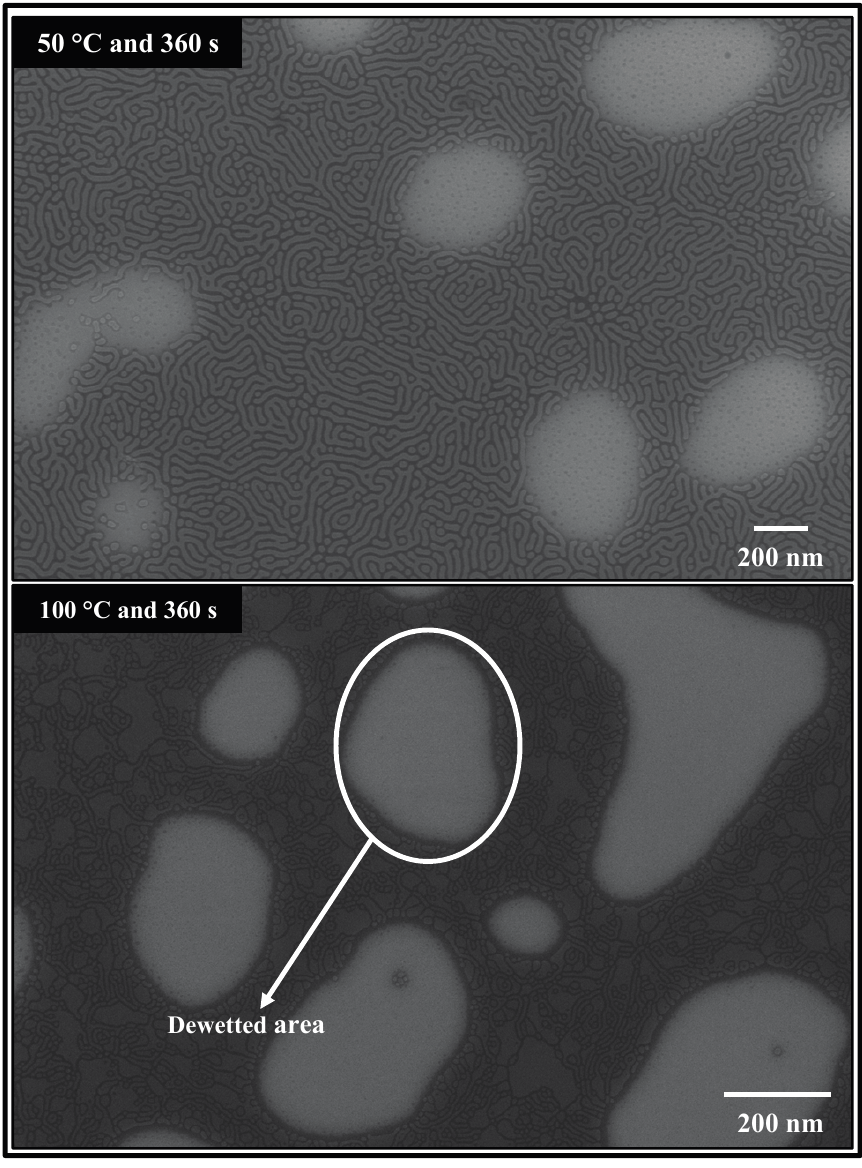
Figure A2. Top-down SEM images of the PS- b -PDMS pattern formed via solvent annealing in the presence of toluene in an oven (in the absence of microwave irradiation) for 360 s at different temperatures as labelled on the